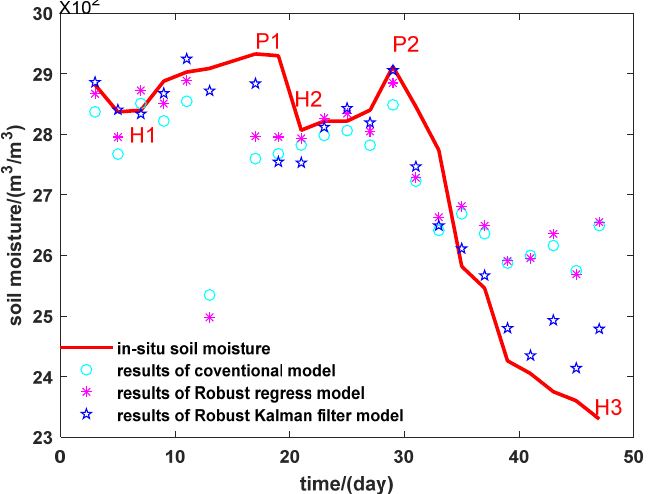
Figure 7. Estimation results of methods by using phase on L1 (PRN1), we highlighted for validation data the main moisture peaks (P1 day 17; P2 day 29) and holes (H1 day 6; H2 day 20; and H3 day 47). We can note that the difference between H1 and P1 is less than 1*10 − 2 m 3 /m 3 and between H2 and P2 it is ~1*10 − 2 m 3 /m 3 which is low and will allow us to test the precision of the inversions and to show the capacity of this technique to differentiate between very weak soil moisture fluctuations.